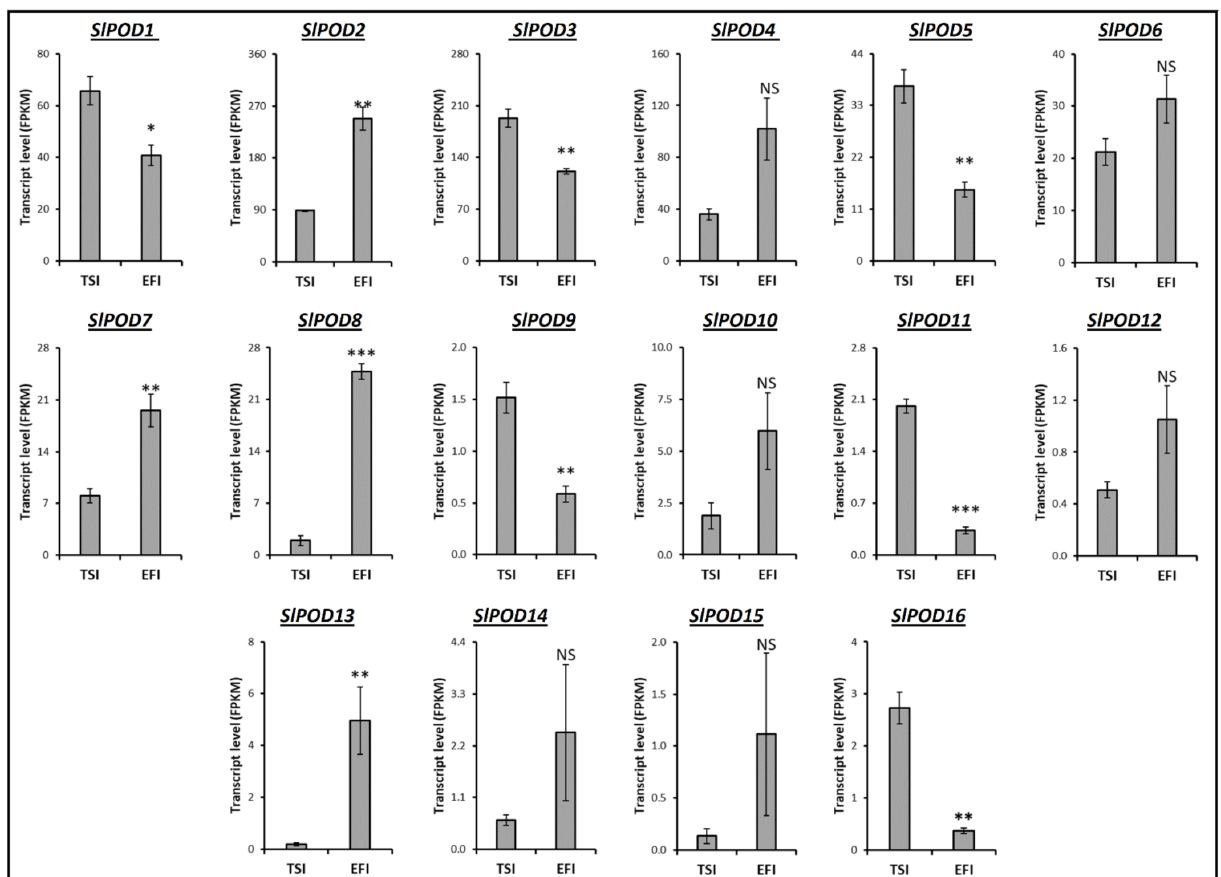
Figure 6. Effect of top sprinkle (TSI) and ebb-and-flow (EFI) irrigation on transcript profiling of POD genes in tomato root. Vertical bars indicate means ± SE (3 biological and 3 techincal replicates). The *, ** and *** represent significance at p ≤ 0.05, p ≤ 0.01 and p ≤ 0.001, respectively, according to Student’s t -test. NS–not